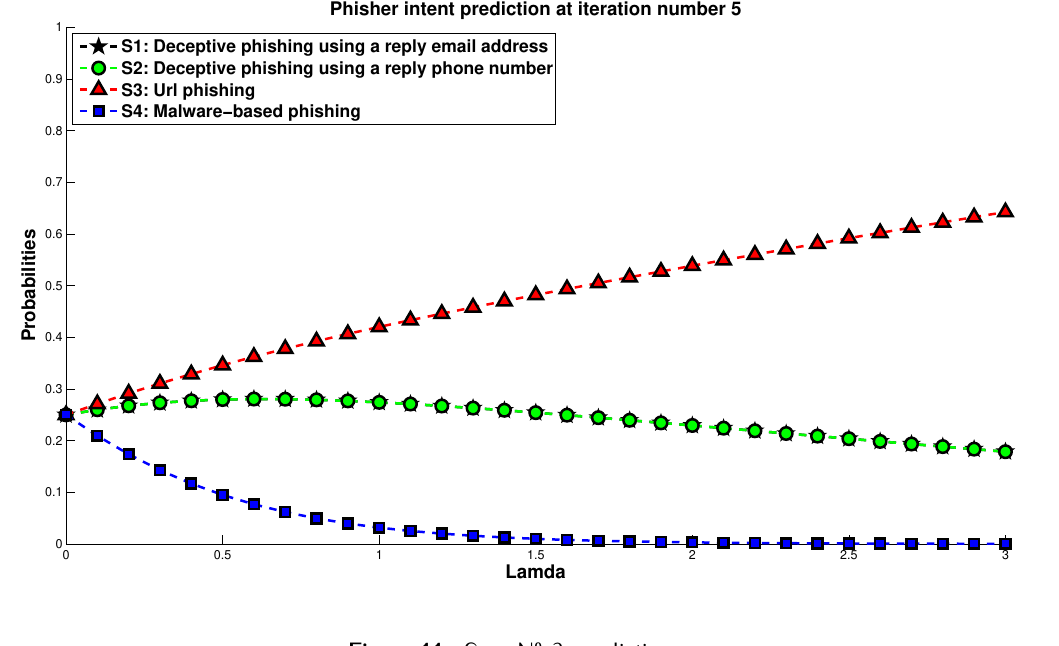
Figure 11. Case N o 3: